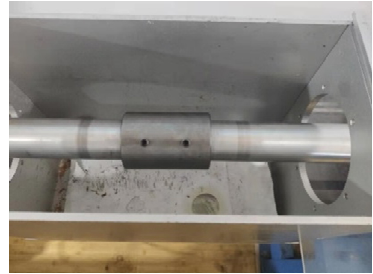
Figure 9. Specimen